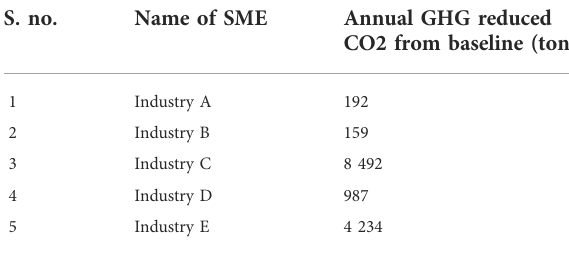
TABLE 12 Total greenhouse gas (GHG) emission reductions. S.